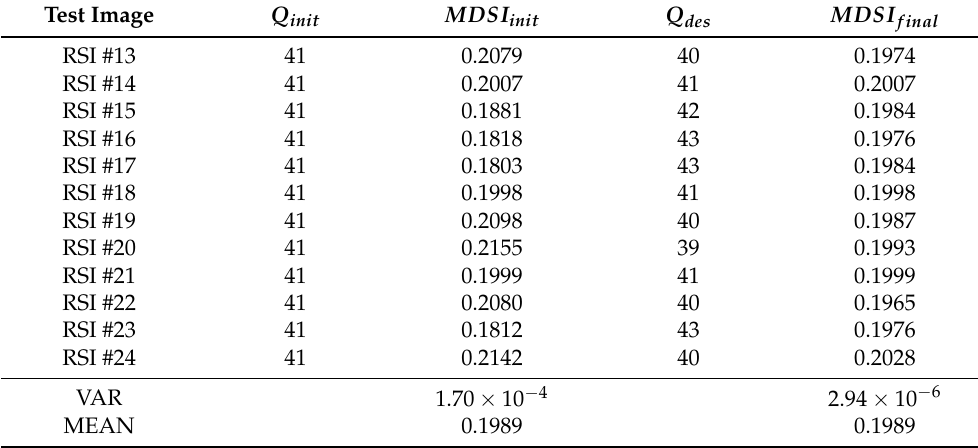
Table A9. The experimental data obtained for the test image set for the desired MDSI =